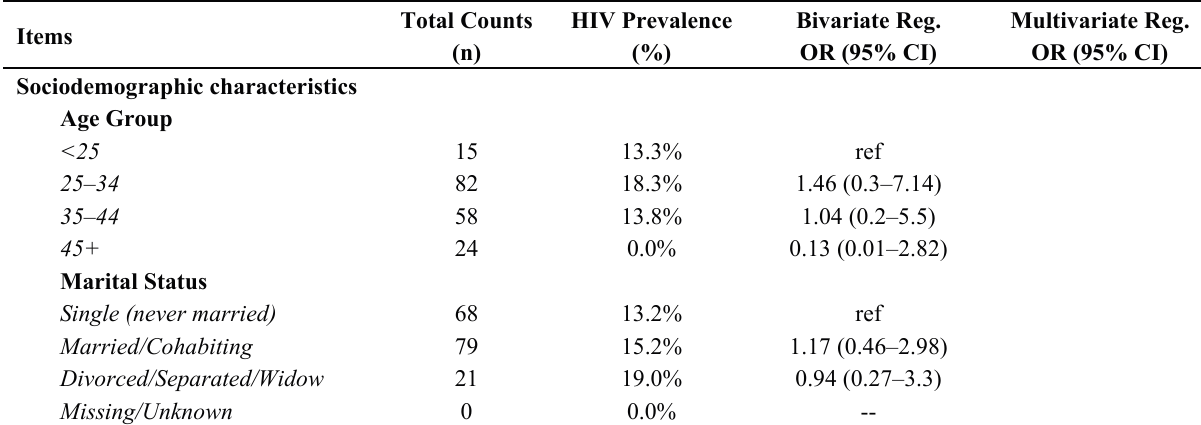
Table 4. Self-reported HIV prevalence and associated factors among female detainees in